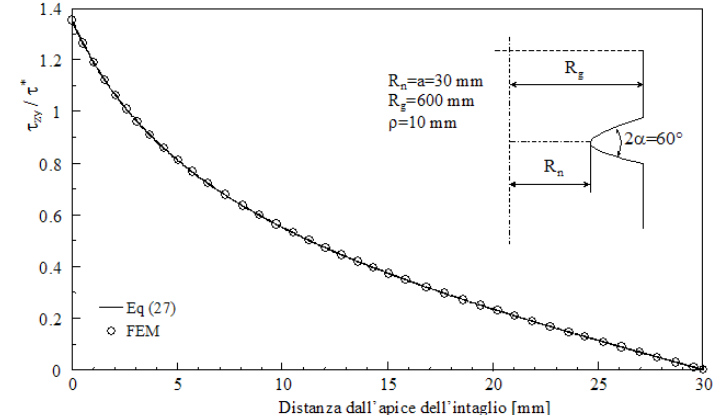
τ lungo la bisettrice dell’intaglio normalizzata Figura 7: Componente di tensione zy rispetto alla tensione nominale sull’area netta.